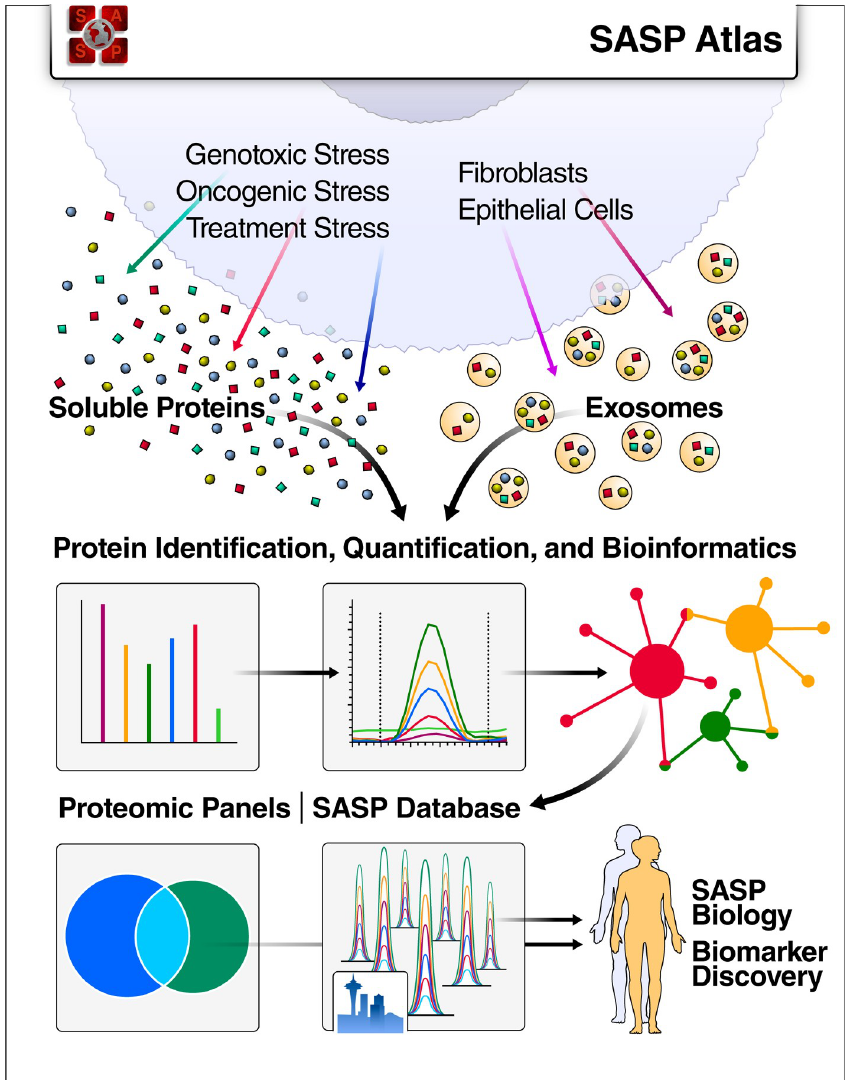
Fig 8. SASP Atlas: A comprehensive resource for SASPs. SASP Atlas (www.SASPAtlas.com) is a curated and freely available database of the secretomes of senescent cells, including both the soluble and exosome SASP, that can be used to identify SASP components or biomarker candidates for senescence burden, aging, and related diseases. SASP, senescence-associated secretory phenotype.